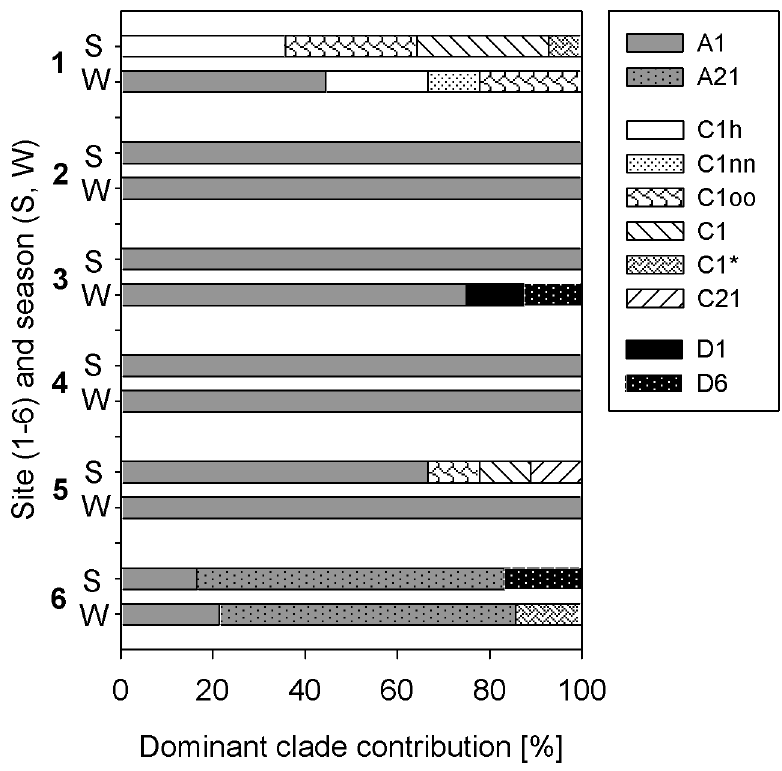
Figure 2. Composition of dominant Symbiodinium clades at all sites from north (1) to south (6) in summer (S, Sep11) and winter (W, Mar12). The rare and new ITS2 sequence found at 1-MAQ named ‘‘C85’’ is not included in the graph.